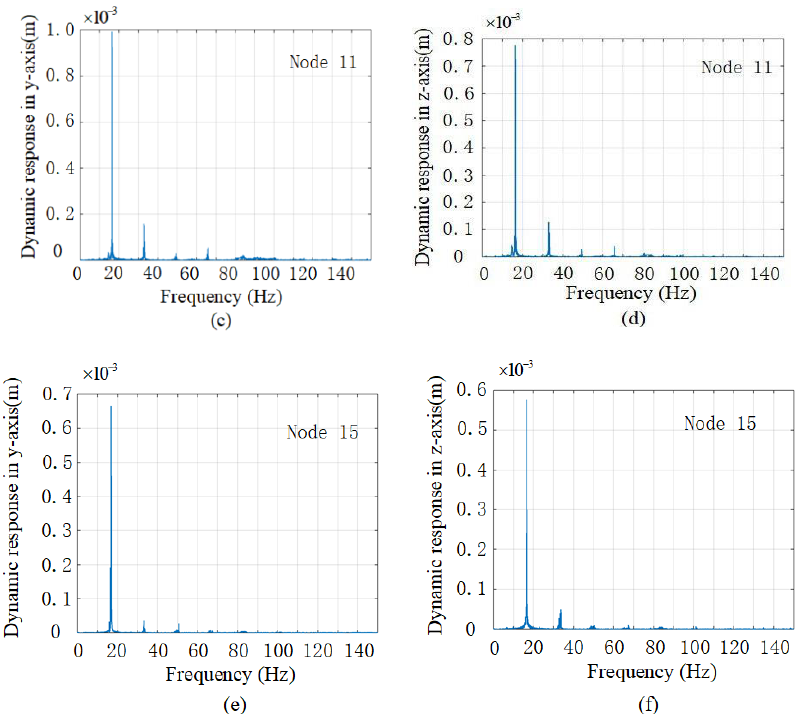
Figure 20. The experimental dynamic response with 0.4 mm parallel misalignment and 0.2 ◦ angular misalignment of nodes 7, 11, and 15 in y -axis and z -axis. ( a ) Node 7 in y -axis. ( b ) Node 7 in z -axis. ( c ) Node 11 in y -axis. ( d ) Node 11 in y -axis. ( e ) Node 15 in y -axis. ( f ) Node 15 in z -axis.